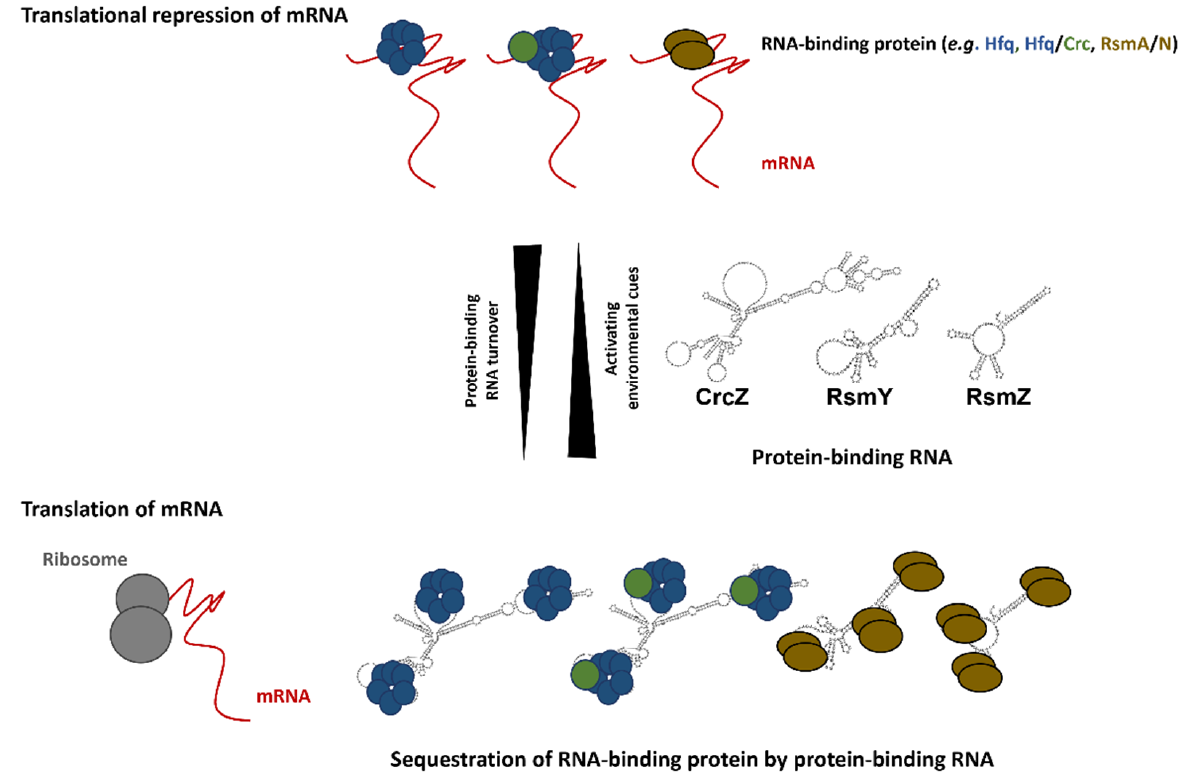
Figure 2. Regulation by protein-binding RNAs. Protein-binding RNAs ( e.g ., CrcZ, RsmY/Z) are activated by environ- mental cues. They contain multiple binding sites for RNA-binding translational repressors ( top ; Hfq (blue hexamer), Hfq in conjunction with Crc (blue hexamer/green circle), RsmA/N (brown circles)). This leads to sequestration of the RNA-binding proteins and to de-repression of their target mRNAs ( bottom ).